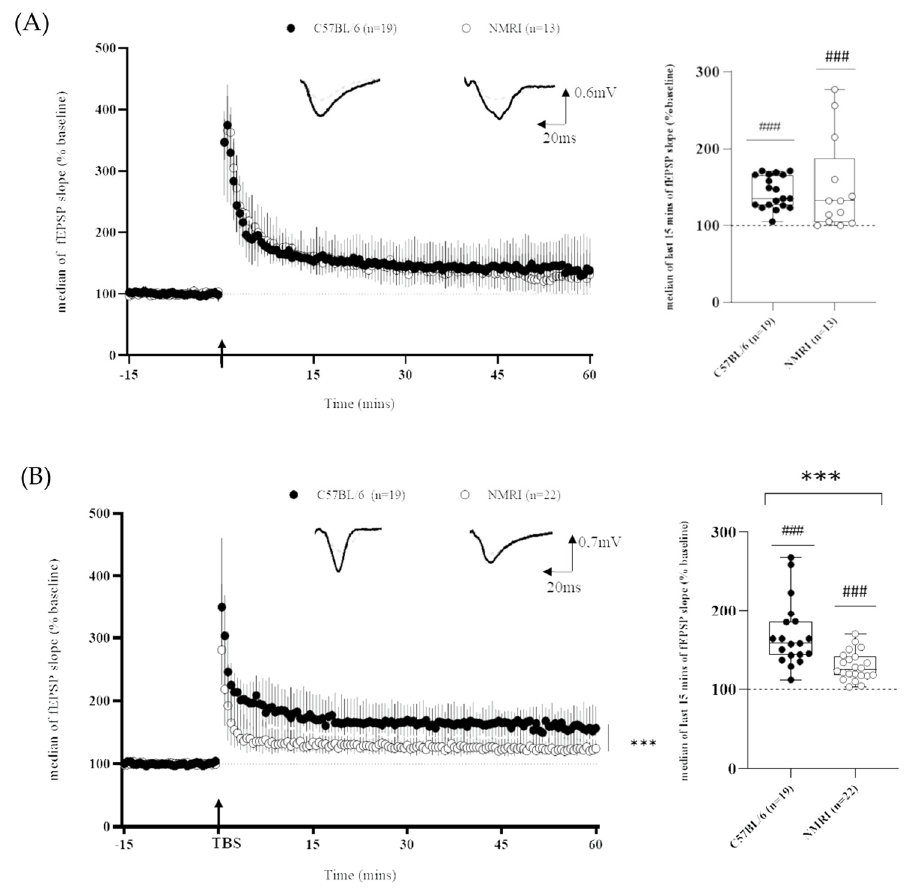
Figure 2. Differential LTP expression in outbred and inbred mice strains depends on stimulating frequency. ( A ) Time course of fEPSP slope after HFS-induced LTP in slices from C57BL/6 mice ( n = 19 slices/ n = 14 mice) and NMRI mice ( n = 13 slices/ n = 10 mice) ( left ) and corresponding last 15 min of fEPSP slope ( right ). ( B ) Time course of fEPSP slope after TBS-induced LTP in slices from C57BL/6 mice ( n = 19 slices/ n = 13 mice) and NMRI mice ( n = 22 slices/ n = 18 mice) ( left ) and corresponding last 15 min of fEPSP slope ( right ). Data are expressed as median ± interquartile. Arrow marks the time when conditioning stimulation was applied. Insets show representative traces of fEPSP before (dashed line) and after (full line) conditioning stimulation (univariate test, ### p <0.001: last 15 min of recording versus theoretical value of 100%; ANOVA for repeated measures *** p <0.001 and Mann–Whitney U test *** p < 0.001 for inbred versus outbred comparison).